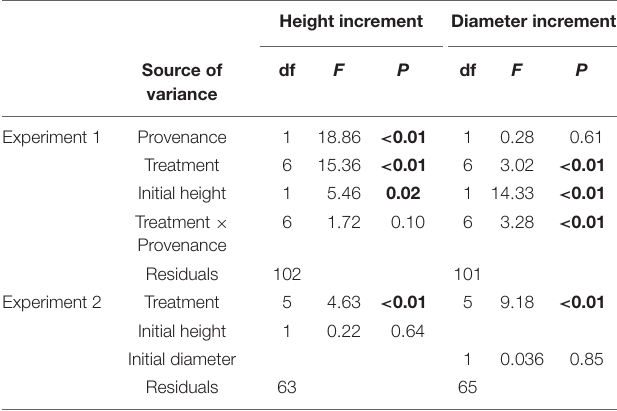
TABLE 2 | Results of analysis of variance (ANOVA) (df: degrees of freedom; F : F -value; P : P -value) from several linear models examining the effect of treatments on plant growth in experiments 1 and